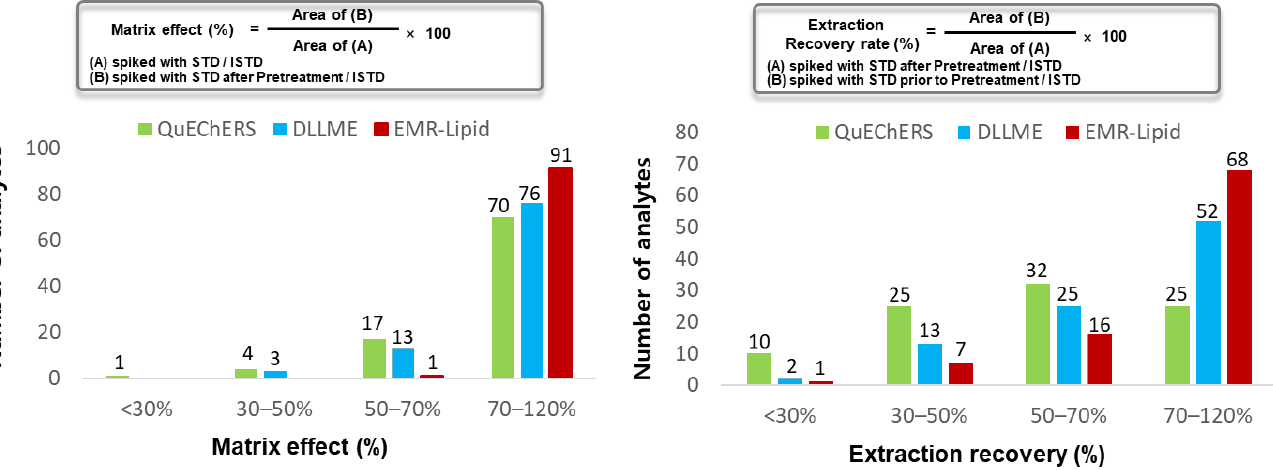
Figure 3. Comparison of matrix effects and extraction recovery for 92 illegal adulterants according to three pretreatment methods.